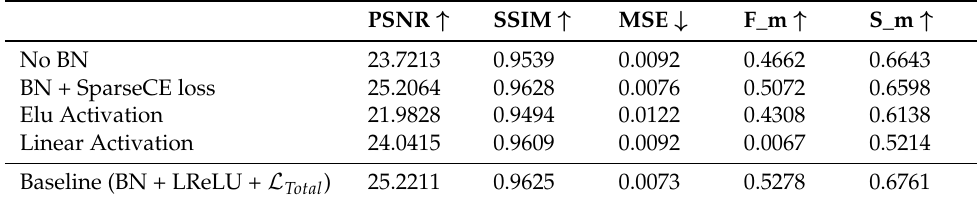
Table 6. Ablation study results of different variations of the SpecSeg